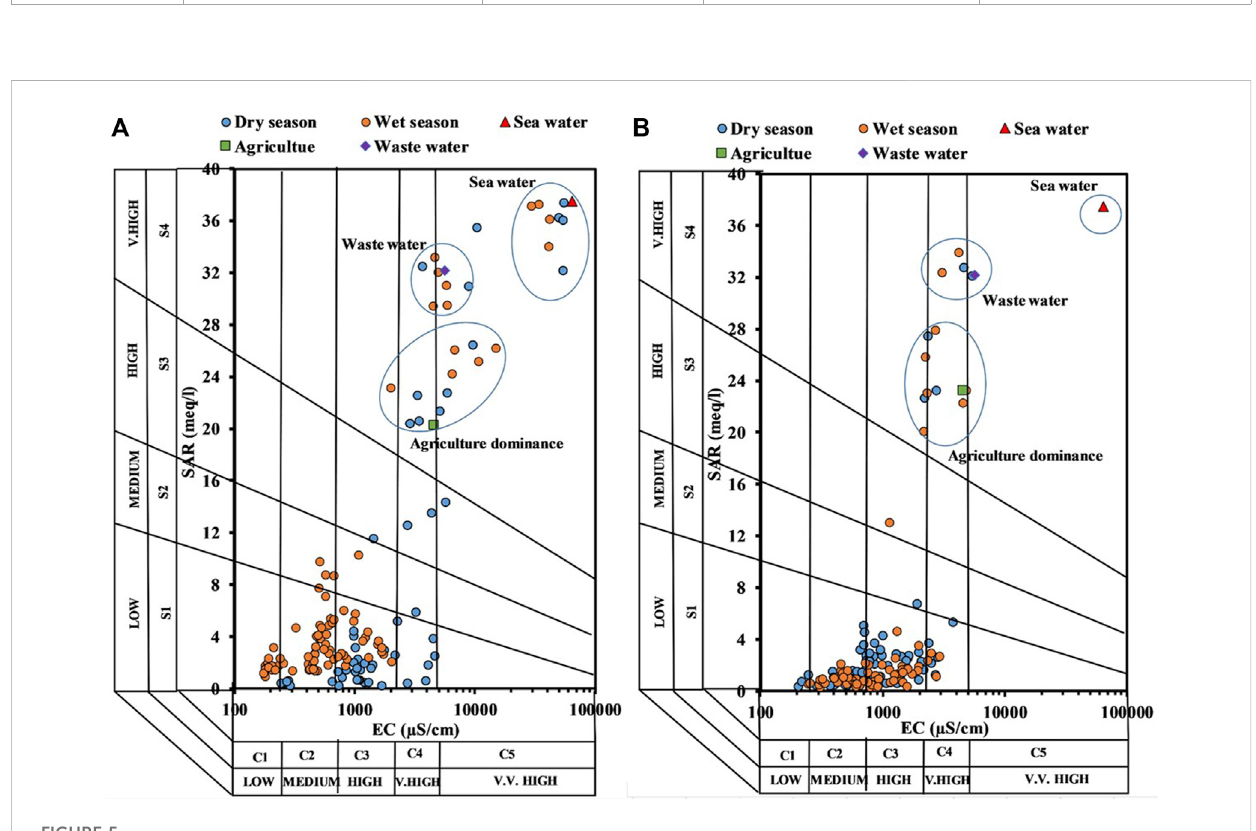
FIGURE 5 Sodium absorption ratio: (A) river water and (B)